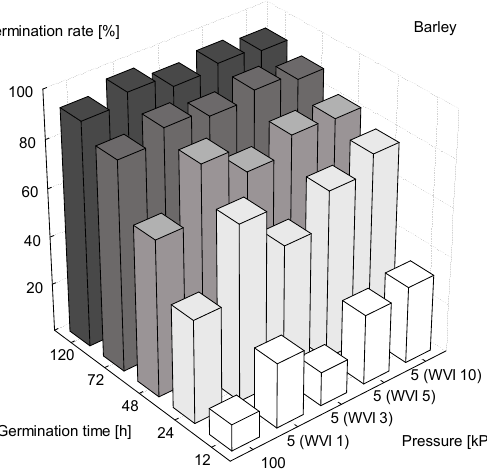
Figure 3. The germination capacity of malting barley cv. Kangoo over time, depending on the method of impregnation (WVI 1—1 cycle of WVI, WVI 3—3 cycles of WVI, WVI 5—5 cycles of WVI, WVI 10—10 cycles of WVI).